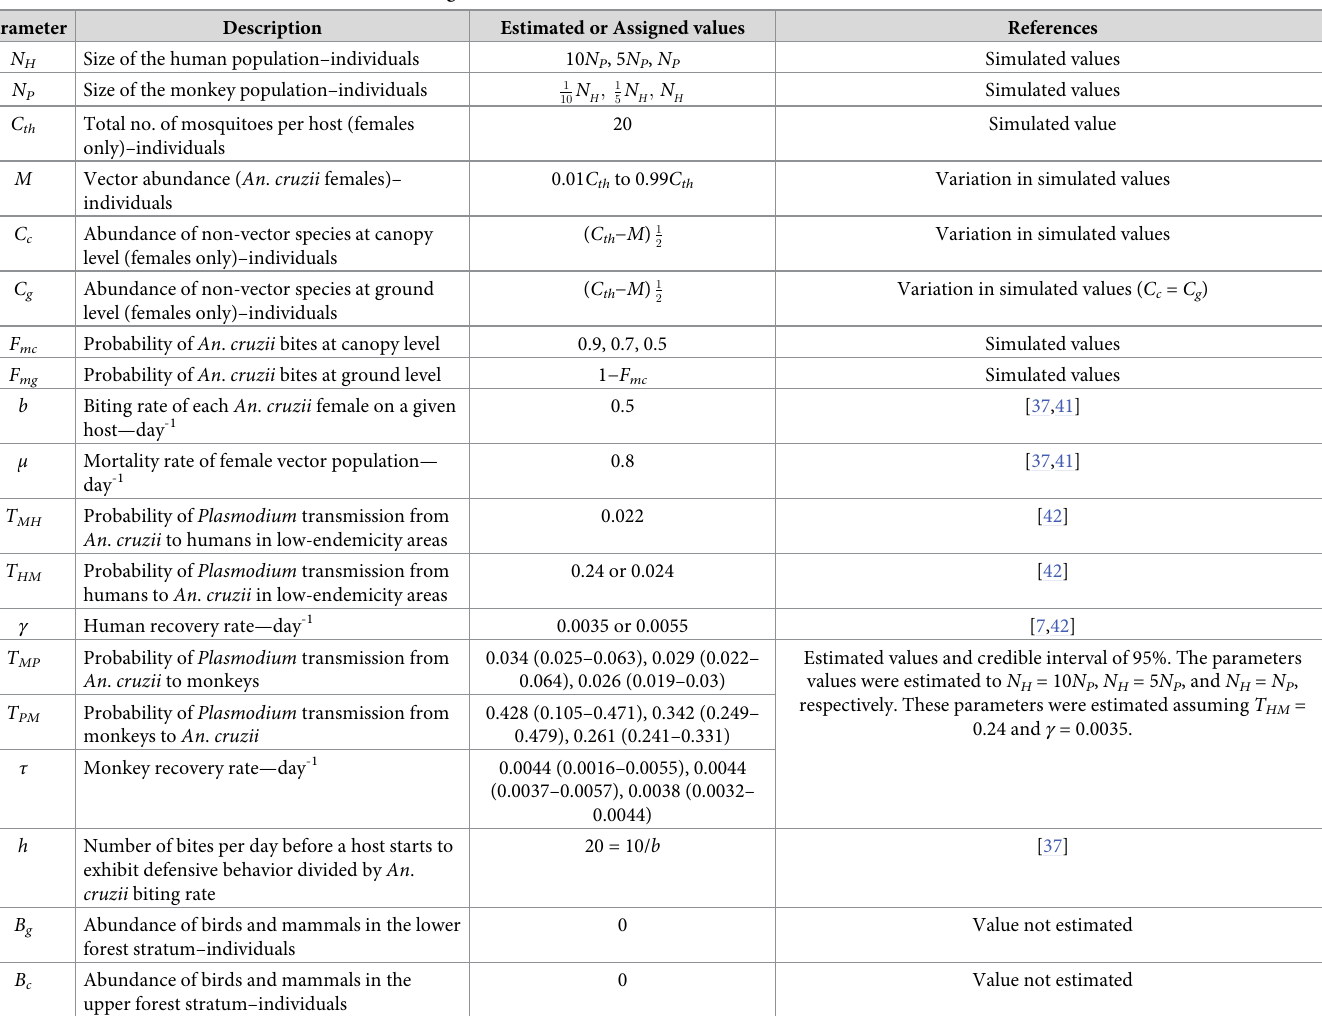
Table 1. Parameters used in the model, estimated or assigned values and